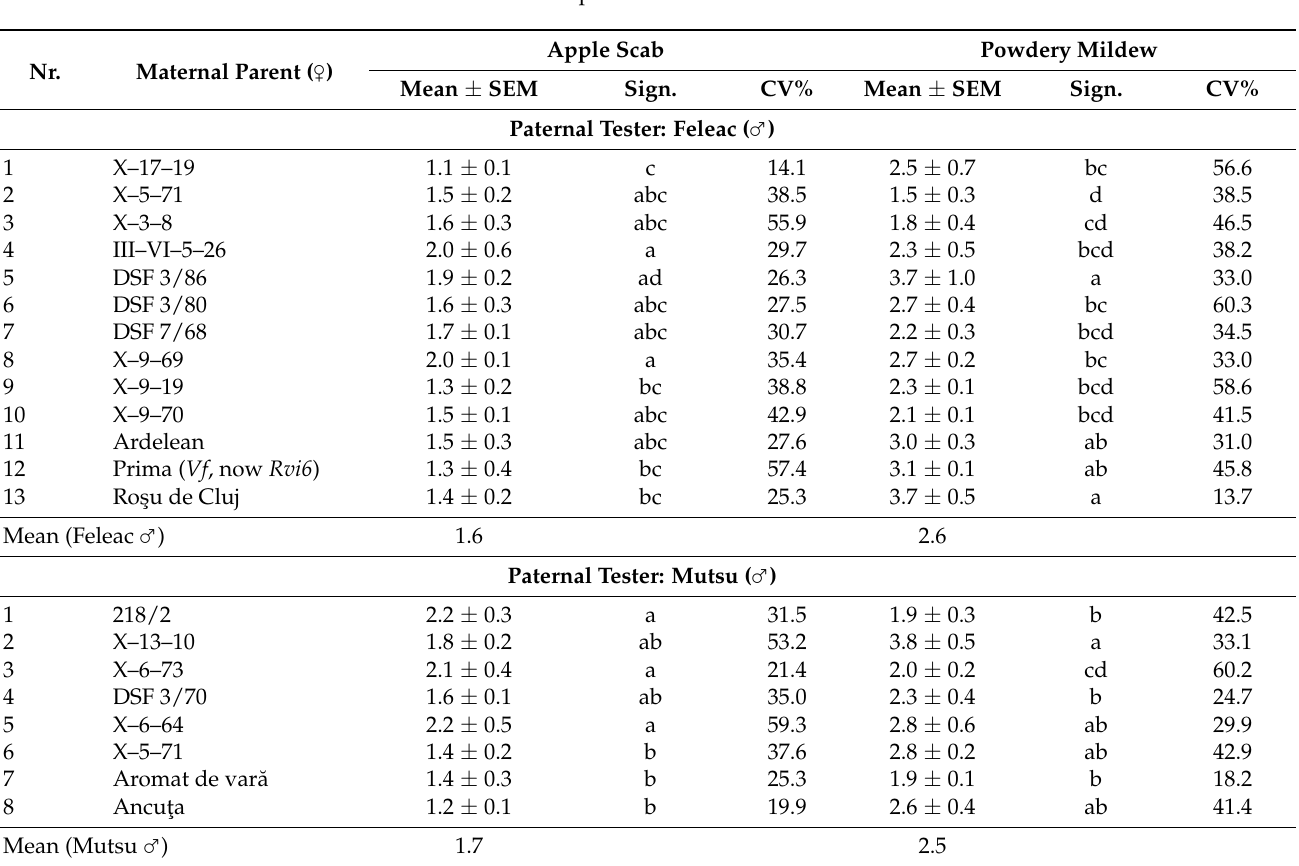
Table A4. Average scores of F 1 apple hybrids from 22 hybrid combinations for apple scab ( Venturia